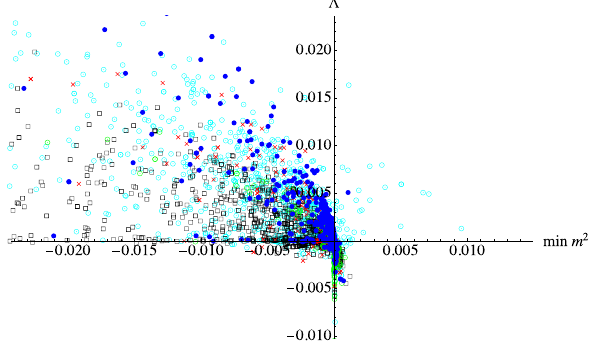
Fig. 5 Landscape found by the hybrid method. The red points are found by using a scalar potential with O3, the blue dots are the vacua found by using O7, the green circles are the critical points found by using O5, the cyan circles are found by employing RR F 5 fluxes and (cid:2) D 5 and the black squares are found by using RR F